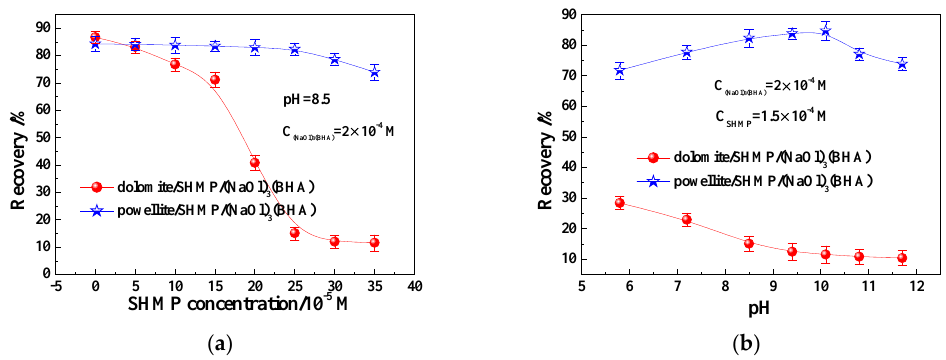
Figure 5 ( a ) Effect of SHMP concentration on mineral recovery using a collector mixture and ( b ) pulp pH on mineral recovery using the depressant SHMP with a collector mixture.